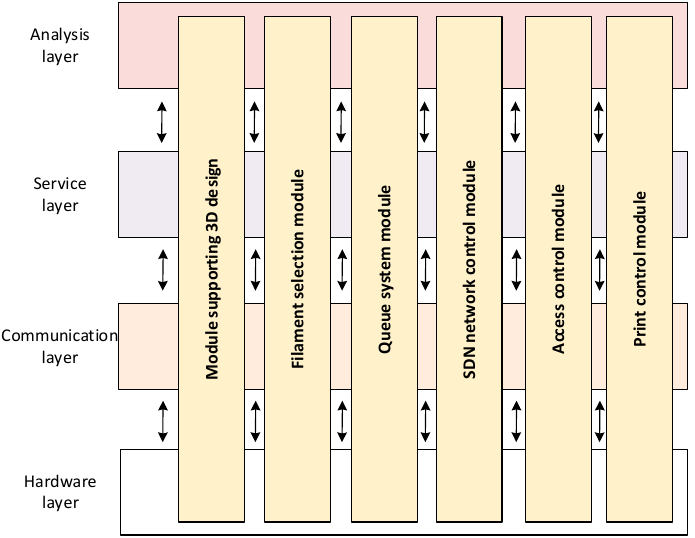
Figure 4. System architecture in the context of the proposed framework.